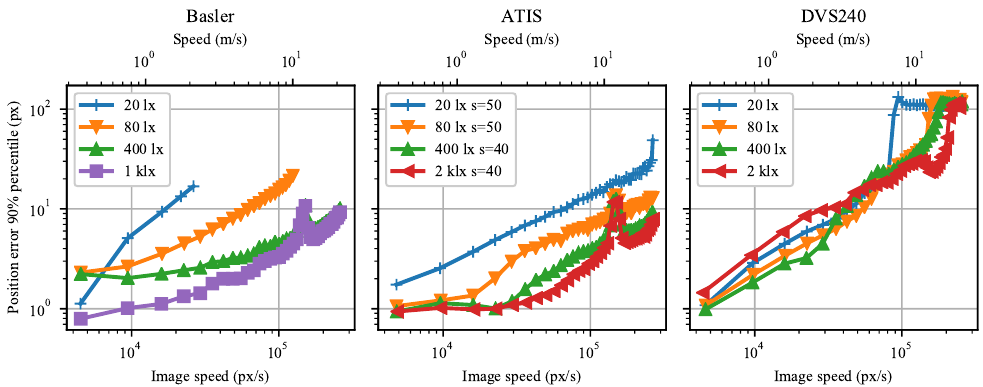
Figure 5. 90% percentile of the position estimation error as a function of dot image speed for Basler, ATIS, and DVS240 cameras. Data were measured for four background scene illuminance levels at the sensor